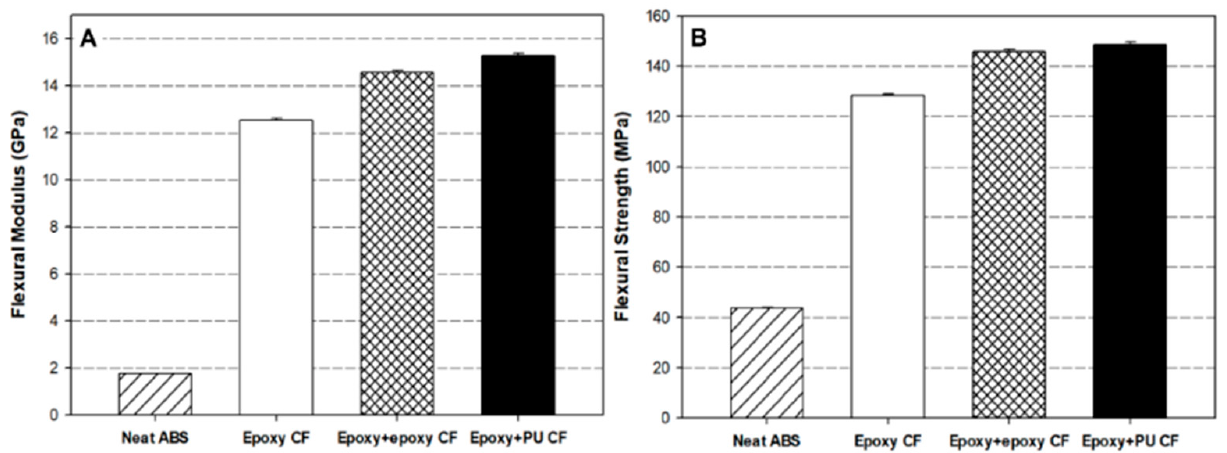
Figure 9. Comparisons of the ( A ) flexural modulus and ( B ) strength of neat ABS and carbon fiber/ABS composites with (epoxy) single-sized and (epoxy + epoxy, epoxy + PU) dual-sized carbon fibers.